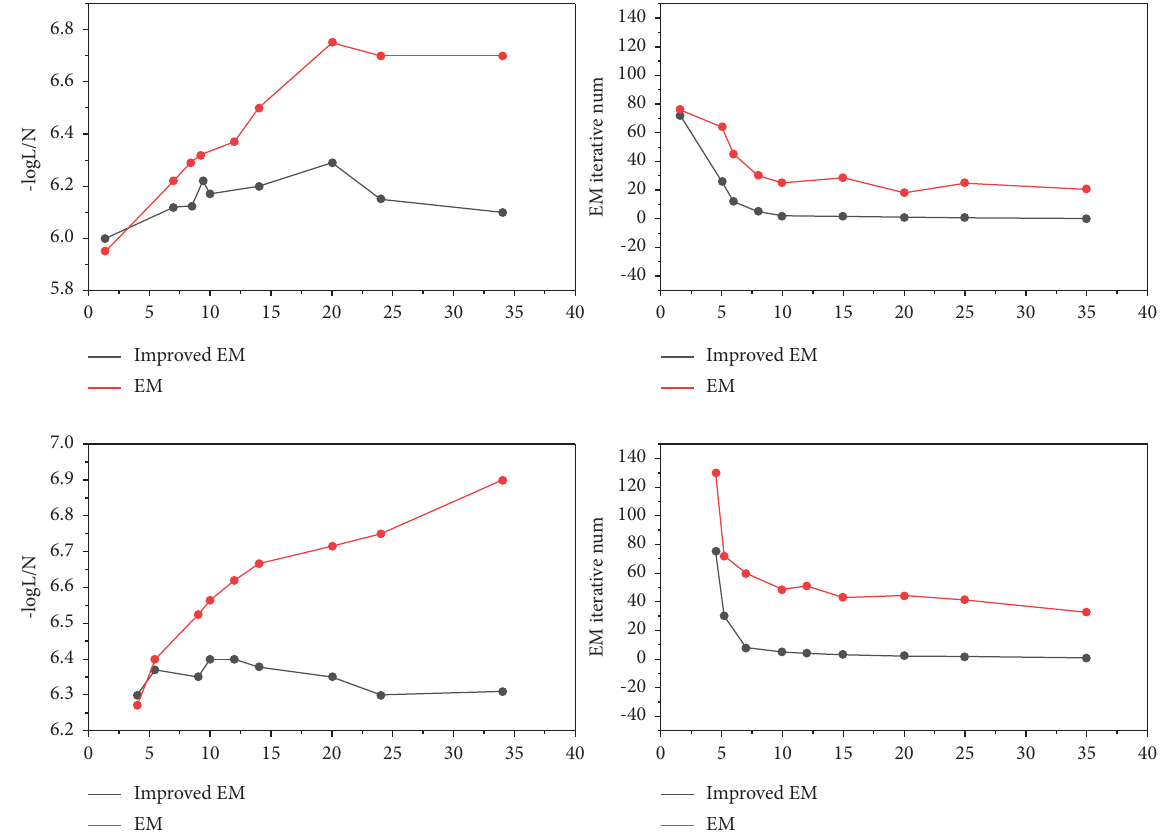
Figure 5: Comparison between the improved EM algorithm and the original EM